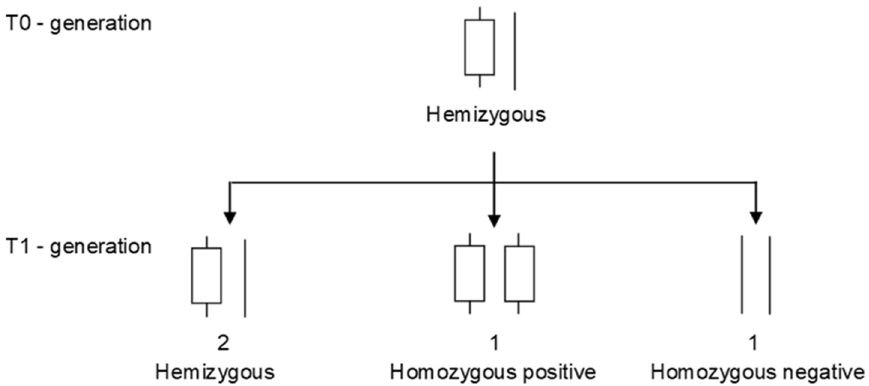
Figure 3. Genetic structure of hemizygous plant T0 and after self-pollination of the resulting progeny T1. Transformed plants regenerated from callus, or after in planta transformation of ger- minating seedlings, are termed T0 plants. T0 plants are always hemizygous, meaning that there is a copy of the transgene at a novel locus in the plant genome; the DNA gets integrated into one chromosome, but not the homolog at the same locus. T0 plants produce T1 seeds, which in turn develop into T1 plants that carry the transgene in either a hemizygous, homozygous positive, or homozygous negative state in an expected 2:1:1 Mendelian ratio if there is a single copy insertion of the